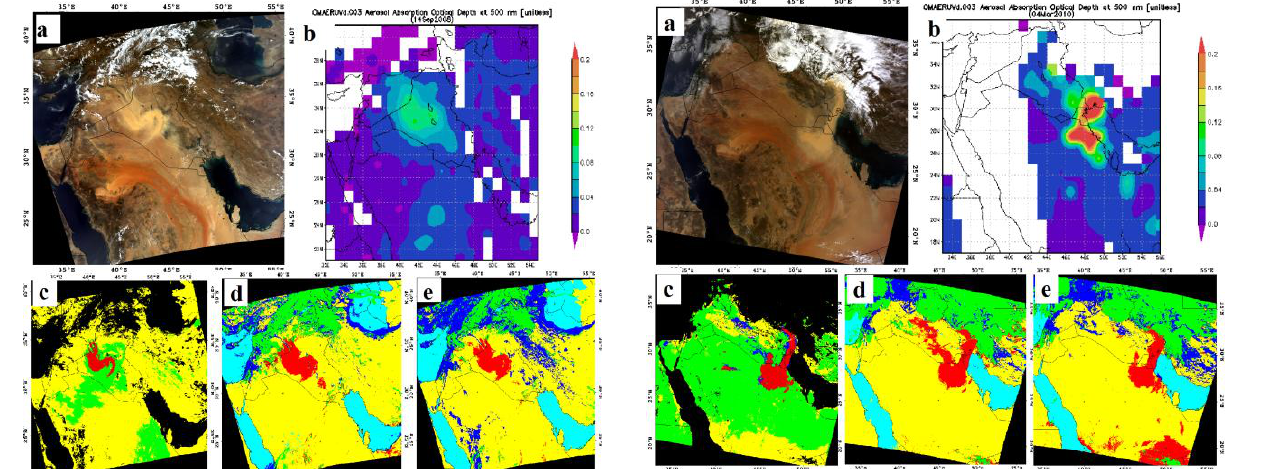
Figure 3. comparison of detected dust storm in 14 Sep 2008 with true color image and OMAERUV product, a)true color image, b) OMAERUV product, c) decision tree result, d) MLP result, and e) SVM result